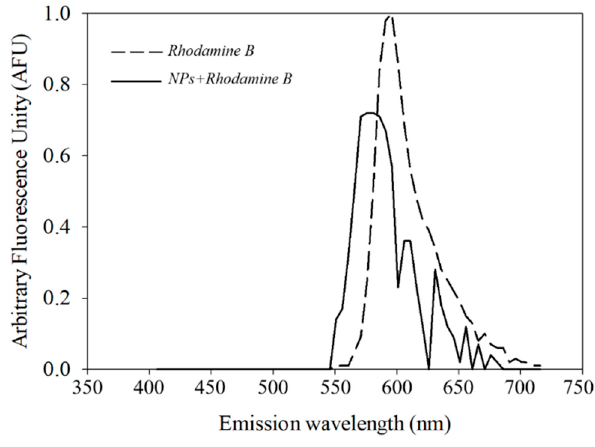
Figure 10. Comparative spectra of fluorescence emission of rhodamine B staining. ( a ) Rhodamine B diluted in water at 1% showed a maximal peak emission at 600 nm. ( b ) Nanoparticles of BSA-capsaicin stained with rhodamine B showed a maximal peak emission at 575 nm.